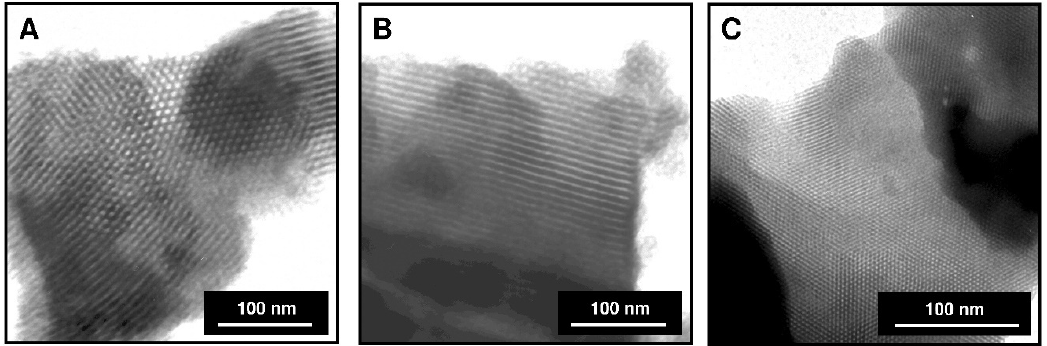
Figure 3. TEM micrographs of ( A ) SBA‐15‐(CH 2 ) 3 ‐SO 3 H, ( B ) PHTS‐(CH 2 ) 3 ‐SO 3 H, ( C ) MCM‐41‐(CH 2 ) 3 ‐SO 3 H mesoporous